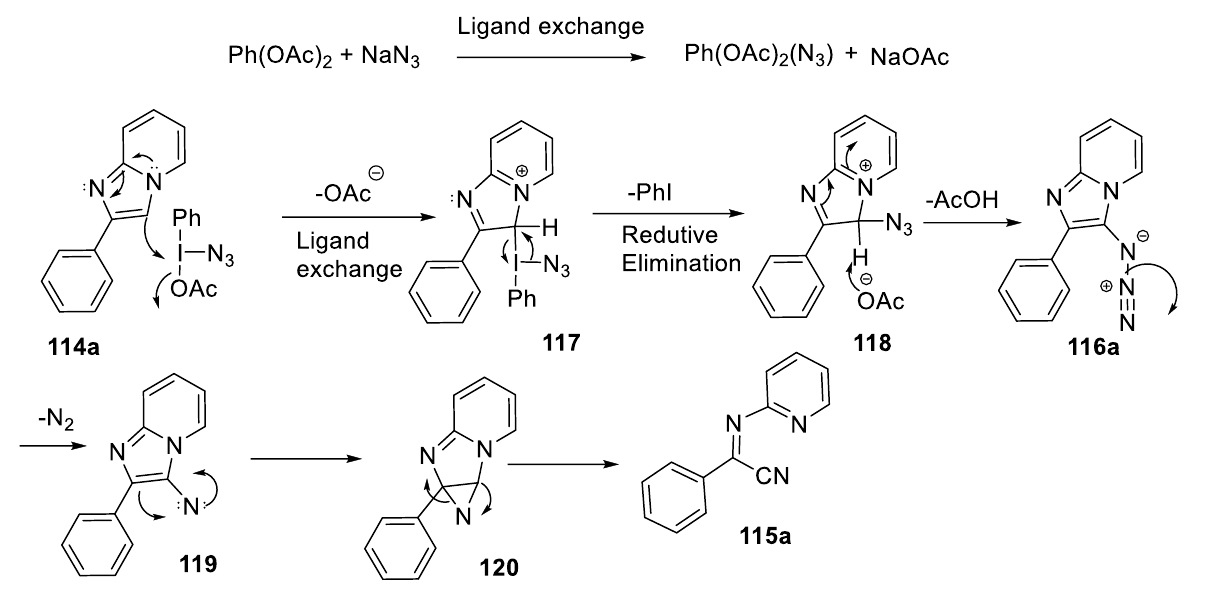
Figure 16. Proposed pathway for the formation of α -iminonitriles.